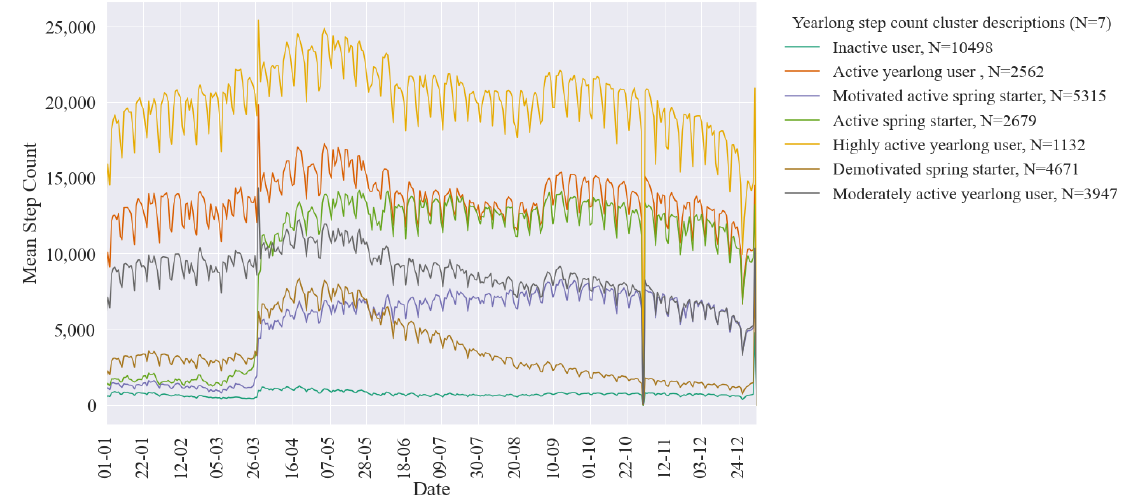
Figure 6. Average daily step counts of yearlong physical activity behaviour clusters (N = number of users assigned to each